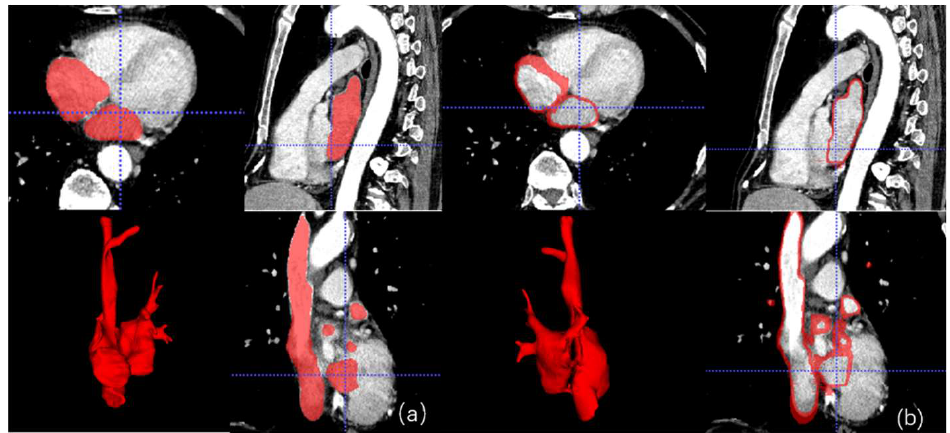
Figure 6. ( a ) Solid and ( b ) hollow bi-atrial computer model showing the segmentation in multiplanar views and a 3D rendering.